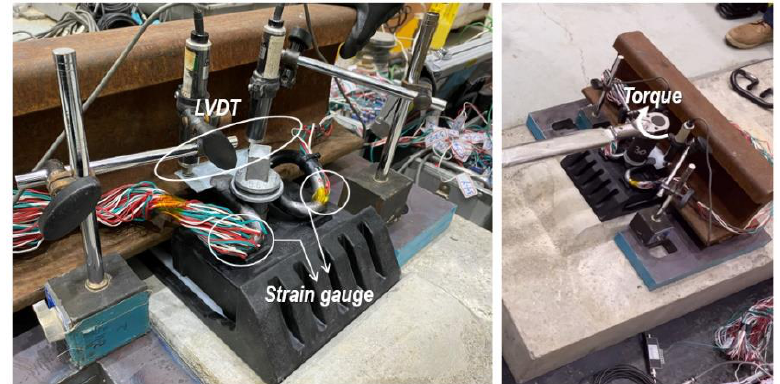
Figure 4. Assembly test setup.